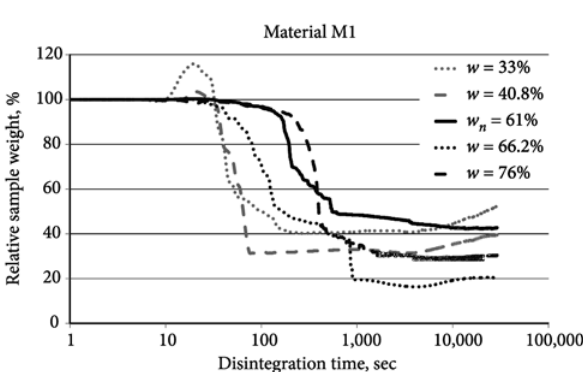
Fig. 5. Disintegration curves (Endell) of material